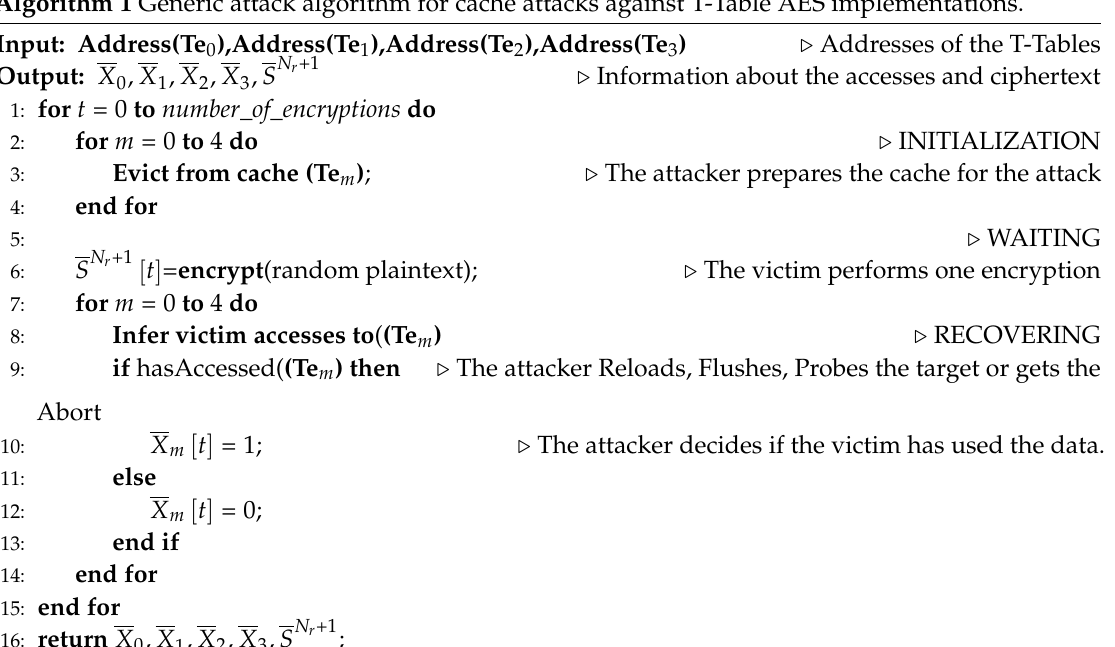
Algorithm 1 Generic attack algorithm for cache attacks against T-Table AES